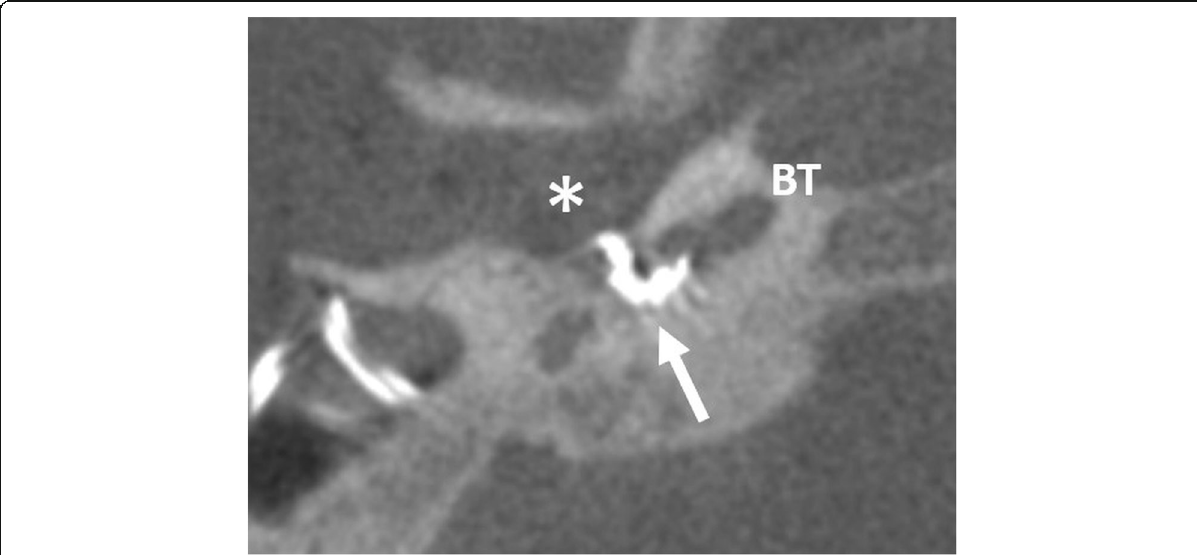
Fig. 31 A 13-year-old female patient, with CHARGE syndrome and malposition of the electrode in the tympanic cavity (asterisk). CBCT axial image shows the apical part of the electrode array (arrow) not passing the angled entry of the round window into the basal turn (BT)